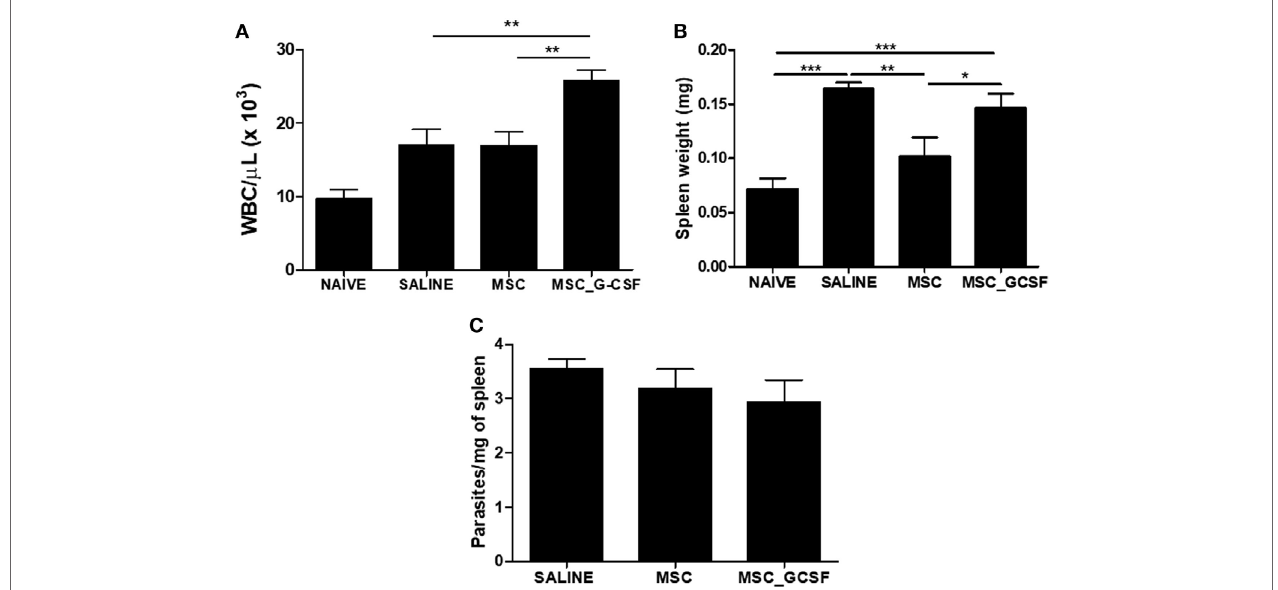
FigUre 5 | Effects of cell therapy on leukocyte mobilization, spleen weight, and parasitism. (a) Peripheral blood leukocyte counts 60 days after the treatment with mesenchymal stem cells (MSCs), MSC_G-CSF, or saline. (B) Spleen weight was found to be increased in infected mice, and decreased by treatment with MSCs, but not MSC_G-CSF. (c) Parasitism in the spleens, evaluated by qPCR, was not altered by the cell therapy. Values represent the mean ± SEM of 7–9 mice/group. * P < 0.05; ** P < 0.01; *** P <